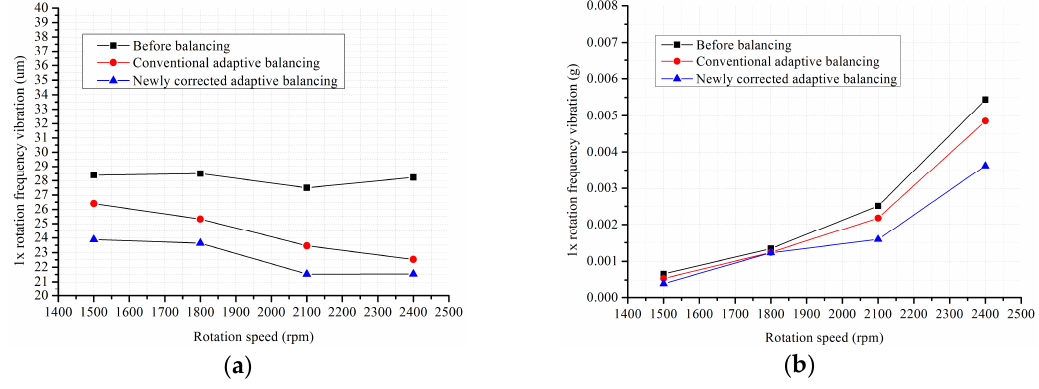
Figure 6. Balancing results for Case 1: ( a ) #2 displacement sensor; ( b ) #2 acceleration sensor.